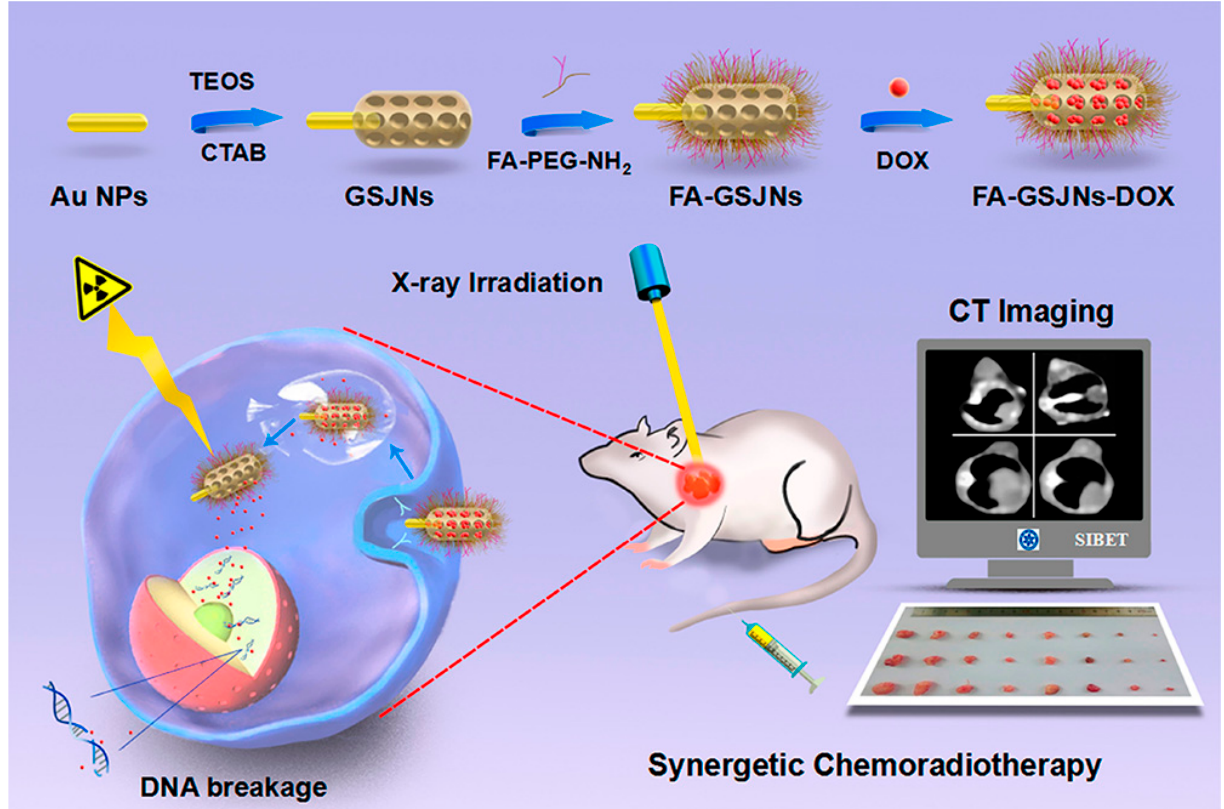
Figure 5. A multifunctional gold-mesoporous silica Janus nanoparticle designed for a bio-imaging system [72]. Table 2. The examples of employed JNPs in the studies related to cancer diagnosis and treatments.